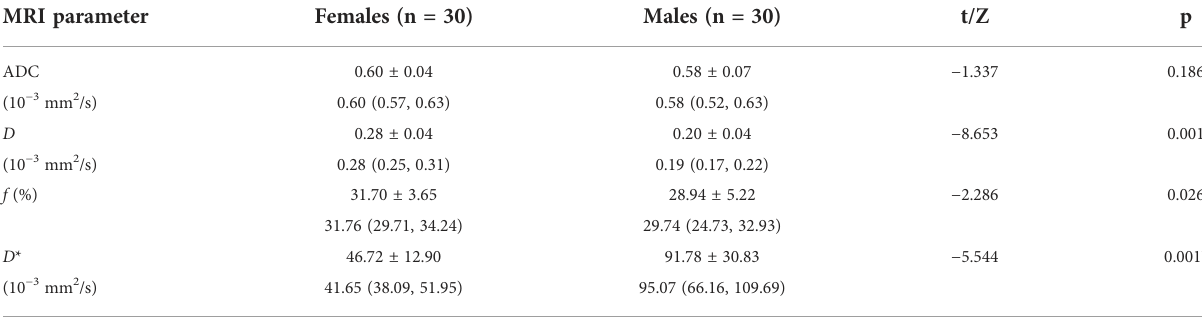
Data are shown as mean ± standard deviation, mean (interquartile range). The independent t-test was applied to compare the two treatment response groups, unless otherwise speci fi ed. # Determined with the Mann – Whitney U-test. Pseudodiffusion coef fi cient (D*) represent the characteristics of perfusion.